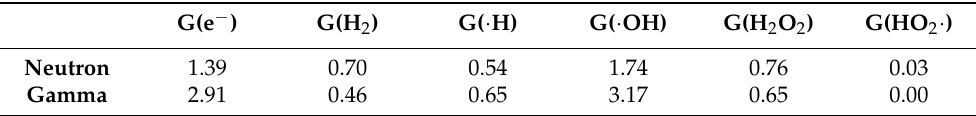
Table 2. The G-values (molecules/100 eV) of primary species for 14 MeV neutrons and gamma radiation deposited in water at 60 °C.